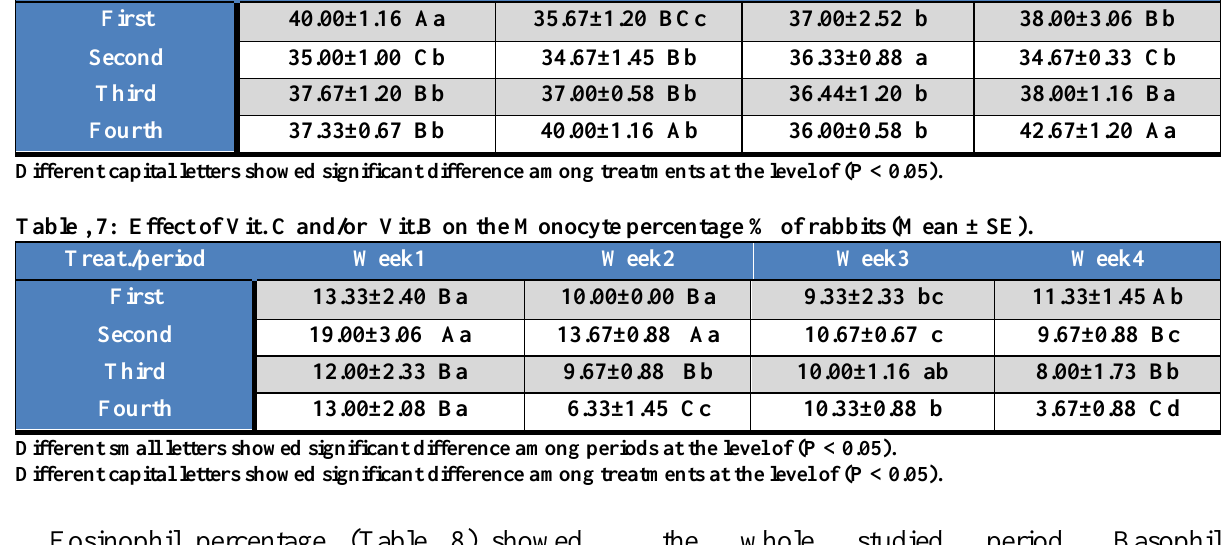
Table, 6: Effect of Vit. C and/or Vit.B on the Neutrophil percentage % of rabbits (Mean ± SE). Treat./period